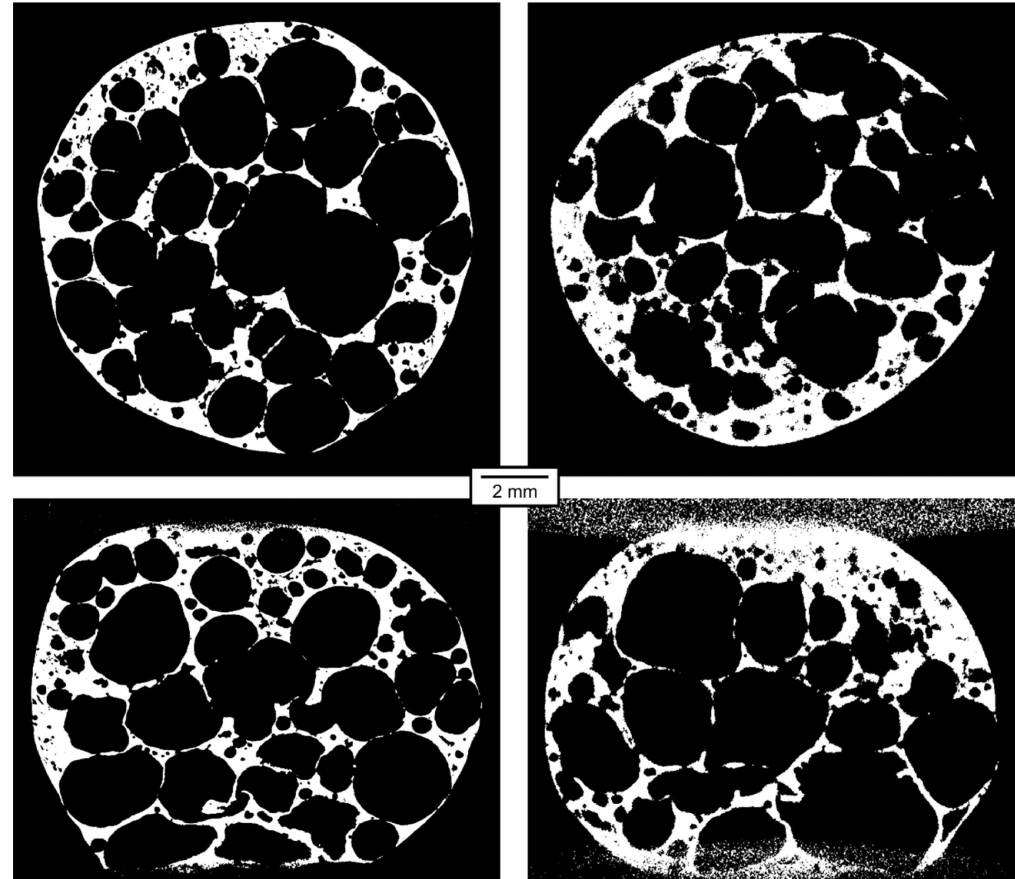
Figure 13. Comparison of the binarized section images from the 3D models reconstructed from the time-lapse tomography, Mode B, deformation 10% ( left ), and on-the-fly tomography, Mode E, deformation 11.4% ( right